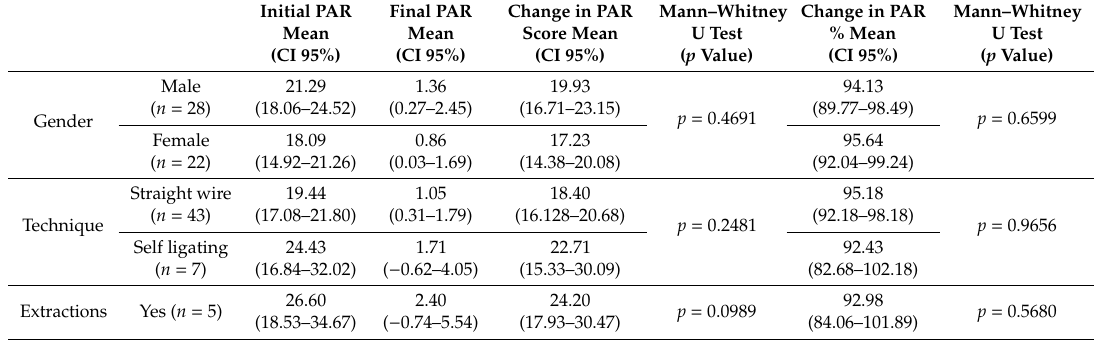
Table 1. Mean PAR distribution related with categorical variables: gender, technique, and extractions.